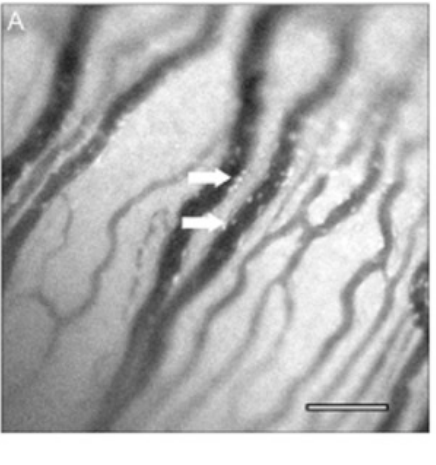
( D ) LPS + AM630+ HU308. Arrows indicate adherent leukocytes. Scale bar = 100 µm. ( E ) Bar graph representing the time course for the mean number of adherent leukocytes for the above groups in- cluding the following: LPS (n = 15); LPS + HU308 (n = 12); AM630 (n = 8); and AM630 + HU308 (n = 7). Values represent the means ± SEM. * p < 0.05 compared with the LPS group. Reproduced from Toguri et al. [88].